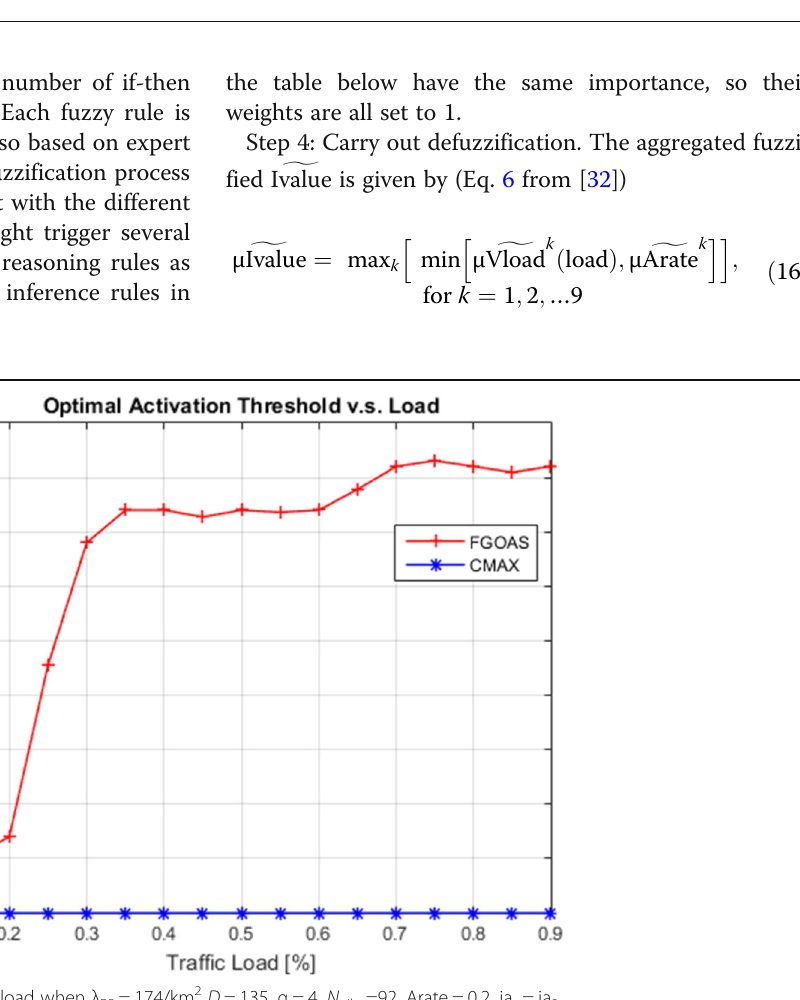
Fig. 10 Optimal activation threshold v.s. traffic load when λ BS = 174/km 2 D = 135, α = 4, N pilot =92, Arate = 0.2, ia x = ia 2